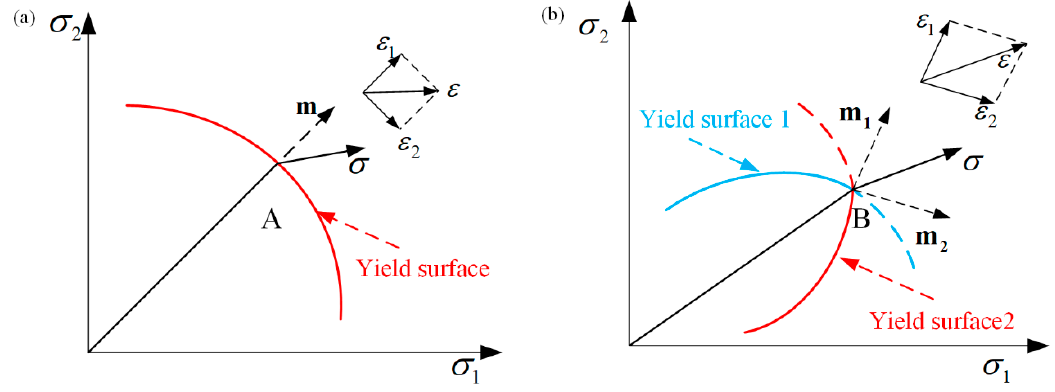
Figure 3. Schematic diagram of Storen and Rice model [48]: ( a ) plastic flow theory with ideal yield surface; ( b ) plastic fl ow theory with singular point.